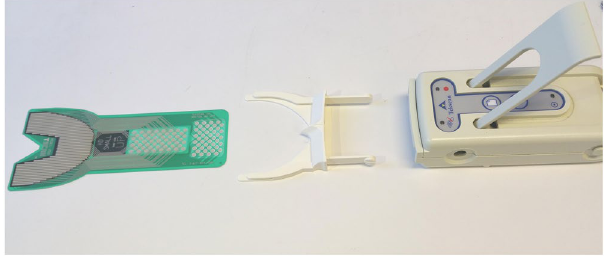
Figure 1. T-Scan system (T-Scan III, Software version 8.0.1, Tekscan, Inc., Boston, MA,